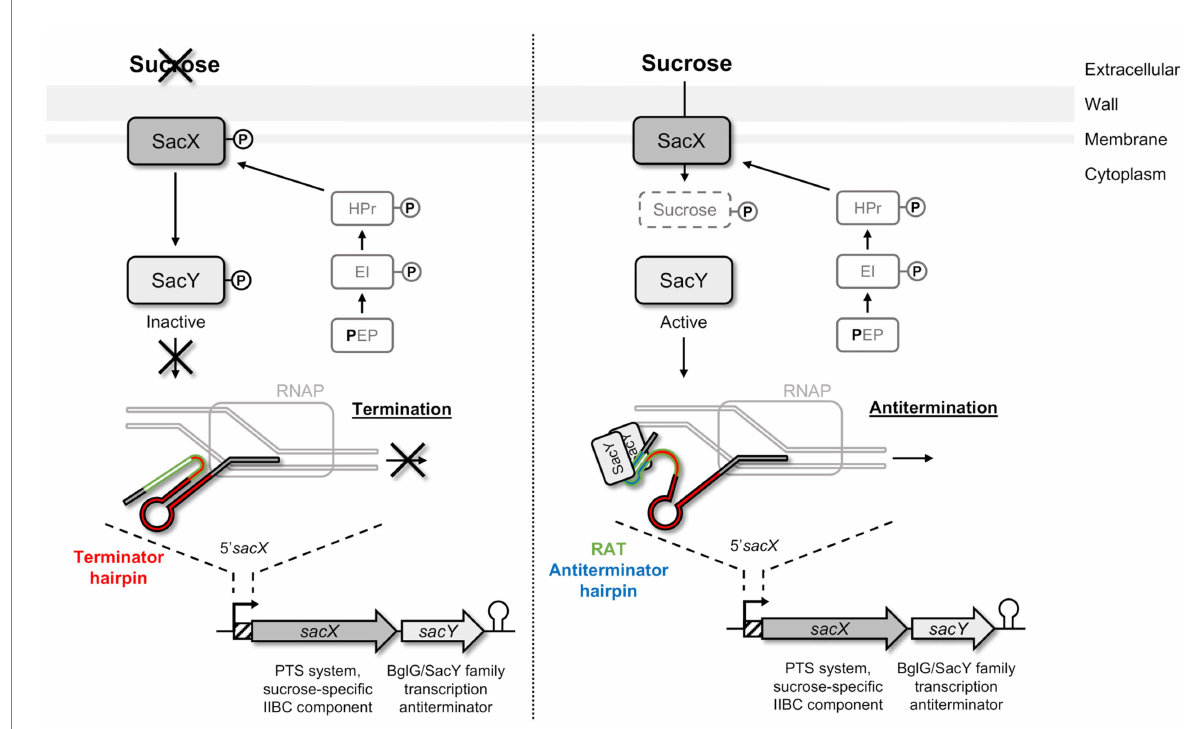
FIGURE 1 Schematic representation of SacY mechanism in Bacillus subtilis . SacX EIIBC enzyme is phosphorylated by HPr from the phosphotransferase system (PTS) pathway, and regulation of sacX-sacY operon occurs depending on the presence of sucrose. In the absence of the specific carbohydrate (left pannel), SacY is phosphorylated and inactivated by SacX. The sacX-sacY transcription is initiated by RNA polymerase (RNAP) but stops by the closing of the terminator hairpin (indicated in red). In the presence of this carbohydrate (right panel), SacY binds its own mRNA on the untranslated region 5’ sacX , and more specifically on the ribonucleic antiterminator sequence (RAT; indicated in green). This interaction promotes the antitermination hairpin (indicated in blue), which prevents the closure of the terminator hairpin, and makes the transcription terminator present on 5’ sacX ineffective (anti-termination). Sucrose is then phosphorylated by SacX during its import into the cell and metabolized (Clerte et al.,